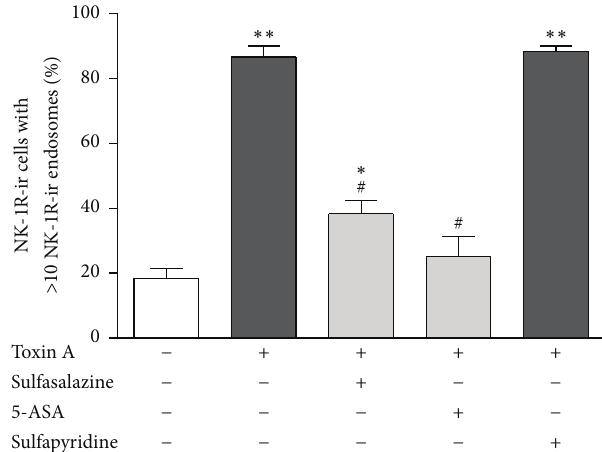
Figure 6: Quantitation of toxin A-induced SP release and its inhibition by sulfasalazine and 5-ASA but not by sulfapyridine. The percentage of NK-1R-ir neuronal cell bodies in the myenteric plexus of the colon with > 10 NK-1R-ir endosomes was determined in 20 cells per animal for each treatment as an index of endogenous SP release. Toxin A stimulated SP release and this effect was signifi- cantly inhibited by sulfasalazine and 5-ASA but not sulfapyridine. ∗ 𝑃 < 0.05 versus no treatment; ∗∗ 𝑃 < 0.001 versus no treatment; # 𝑃 < 0.001 versus toxin A alone